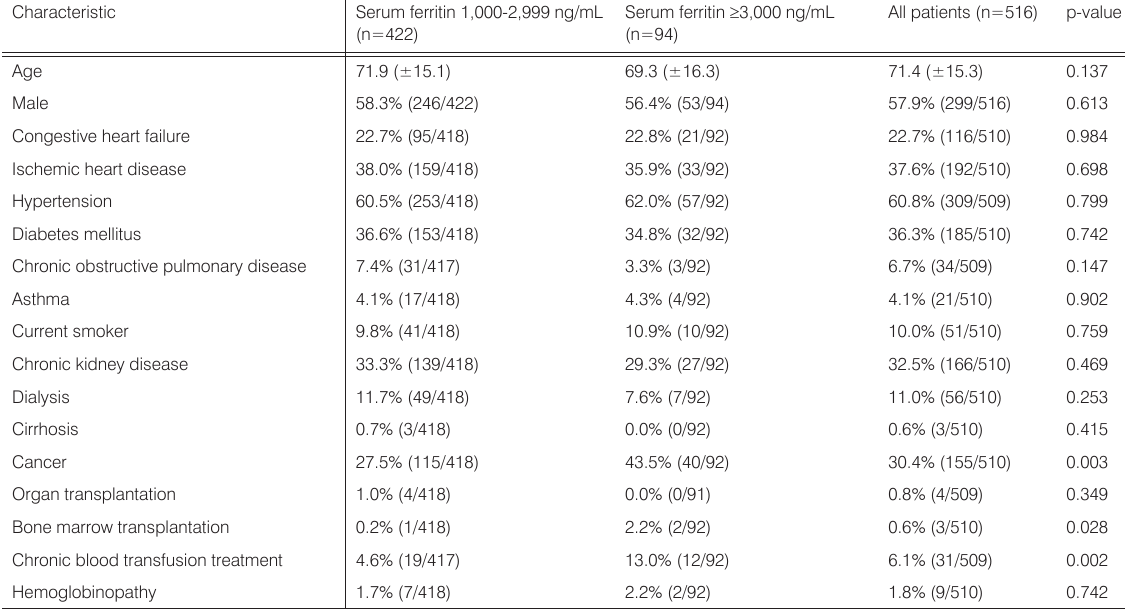
Table 1. Patients Clinical Characteristics